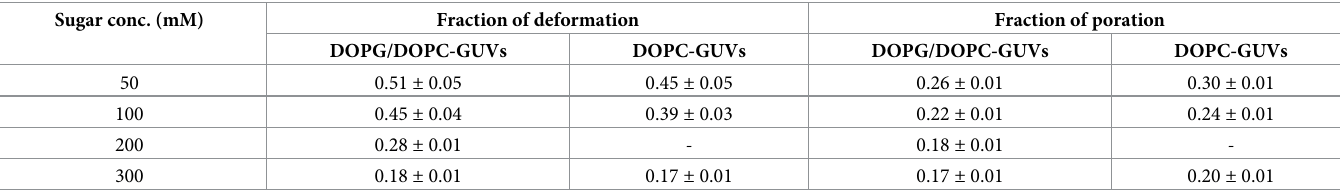
Table 1. Fraction of deformation and poration in 40%DOPG/60%DOPC-GUVs and DOPC-GUVs for 3.33 μ g/mL NPs at 40 min. Sugar conc. (mM) Fraction of deformation Fraction of